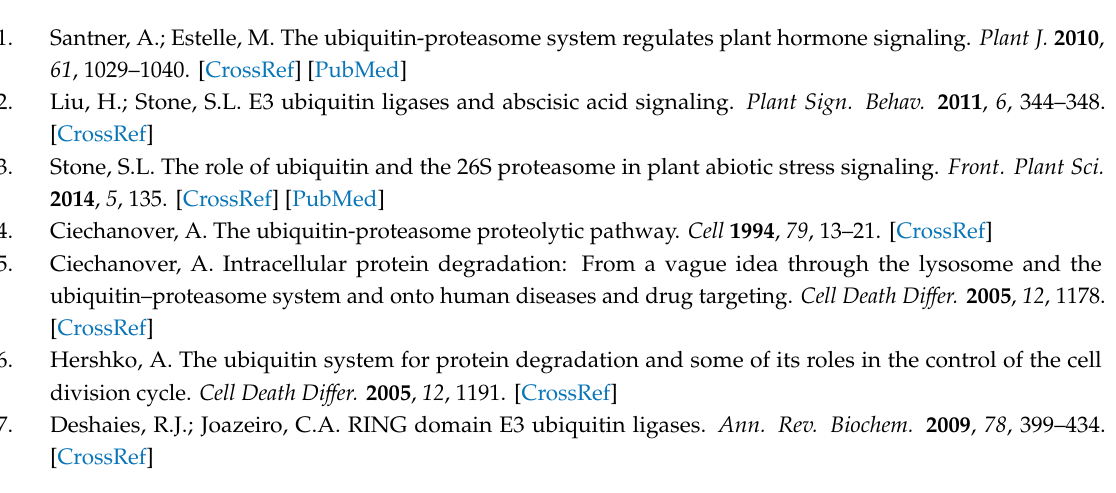
Figure S1: Schematic diagram of HECT gene structures in the encoded genome of Arabidopsis thaliana , Brassica rapa and Brassica oleracea , Figure S2: Sequence logos for the 15 most conserved motifs identified among the HECT domains of Arabidopsis thaliana , Brassica rapa and Brassica oleracea HECT proteins shown in Figure 2, Figure S3: Ka / Ks annotated evolutionary tree of the HECT proteins genes from Arabidopsis thaliana , Brassica rapa , and Brassica oleracea , Figure S4: Expression values of Arabidopsis thaliana HECT genes in 47 developmental tissues, Figure S5: Expression patterns of Arabidopsis thaliana HECT genes in shoots (16 days after germination) under salt (A) and drought (B) stresses, Figure S6: Protein sequences of all HECT genes analyzed in this study, Table S1: List of identified Brassica rapa ( Bra -) and Brassica oleracea ( Bol -) HECT genes and their related Gene Ontology (GO) terms and chemical or physical information, Table S2: Primers used for quantitative real-time PCR